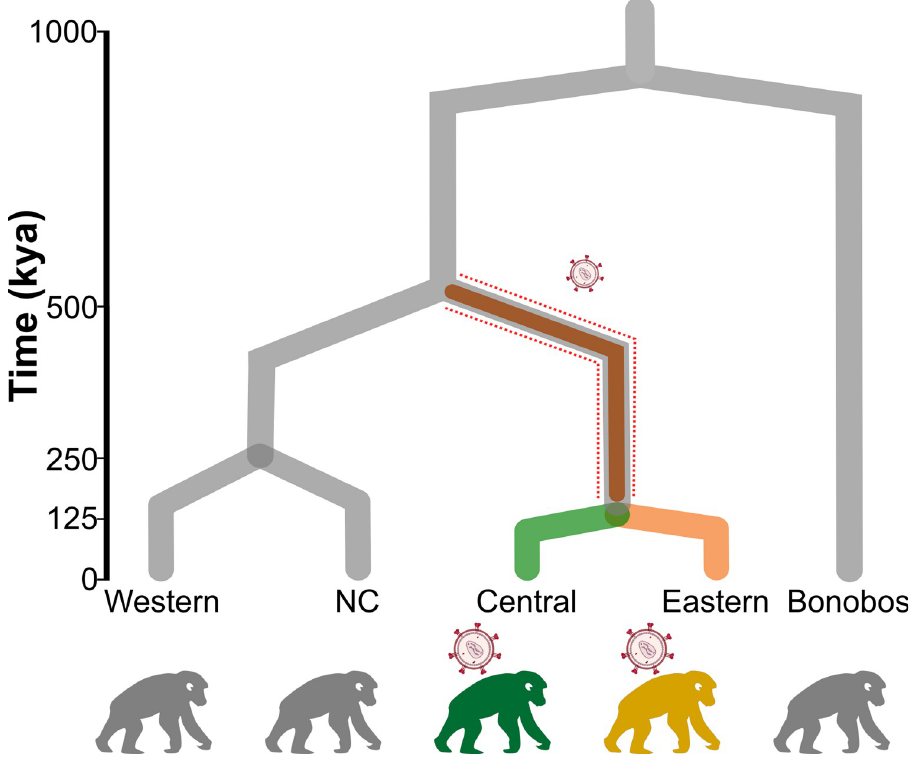
Fig 1. Phylogeny of chimpanzee subspecies and bonobos with the distribution of natural SIV infection. The dotted red line indicates the central-eastern ancestor where the first SIV infection possibly occurred, for which we investigate positive